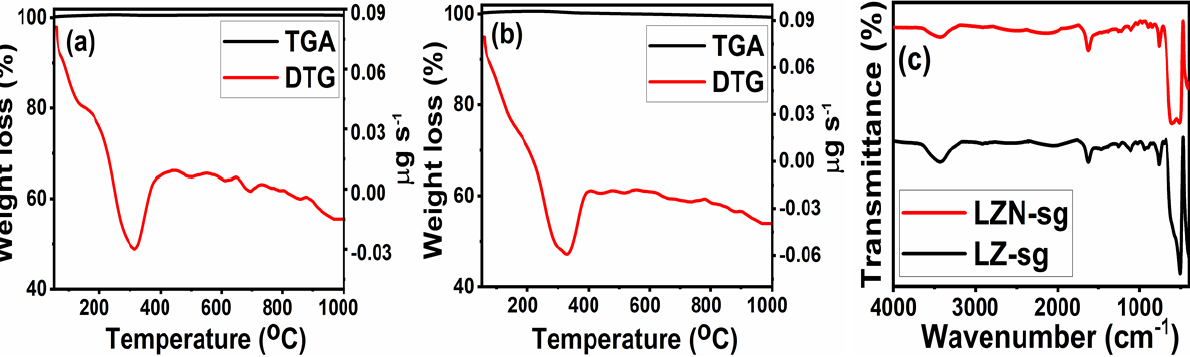
Figure 2. TGA-DTG curves of ( a , b ) LZ-sg and LNZ-sg by the sol-gel route; and ( c ) FT-IR spectra after thermal degradation.